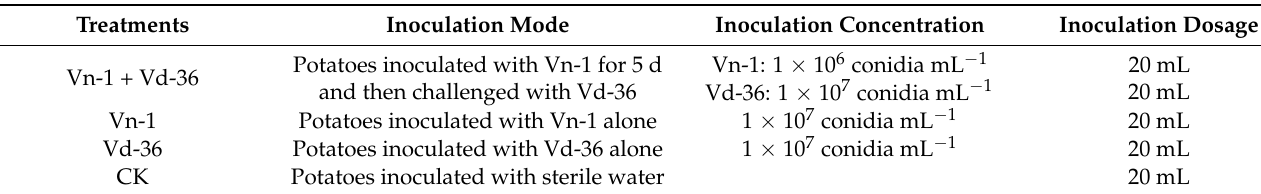
Table 2. Four different experimental groups.